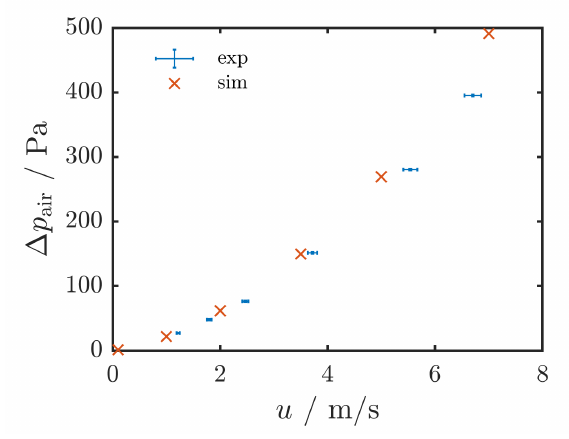
Figure 8. Experimental and numerical results for air-side pressure drop ∆ p air as a function of the air inlet velocity u